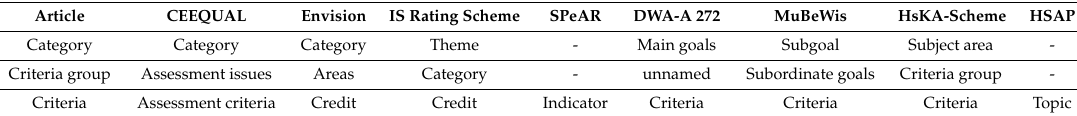
Table 1. Comparison of